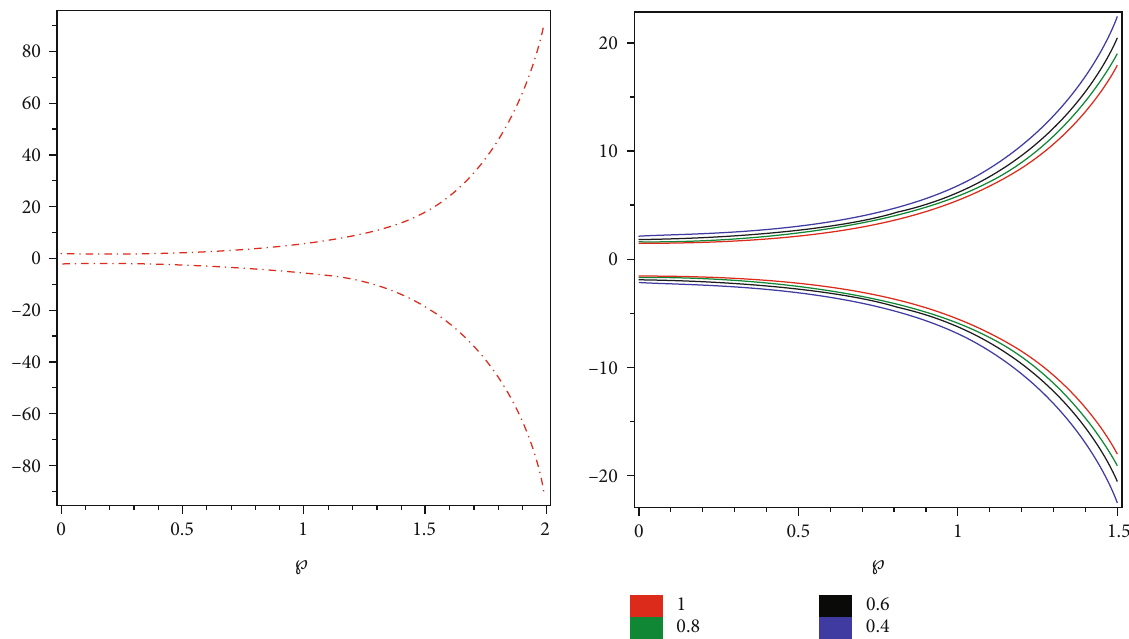
Figure 1: The 1st graph illustrates a two-dimensional fuzzy upper and lower branch graph for an analytic series, while the second illustrates numerous fractions of ρ